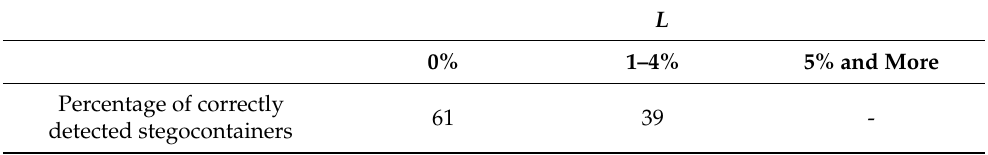
Table 3. RS analysis on a set of 225 × 225 empty containers (800 images).